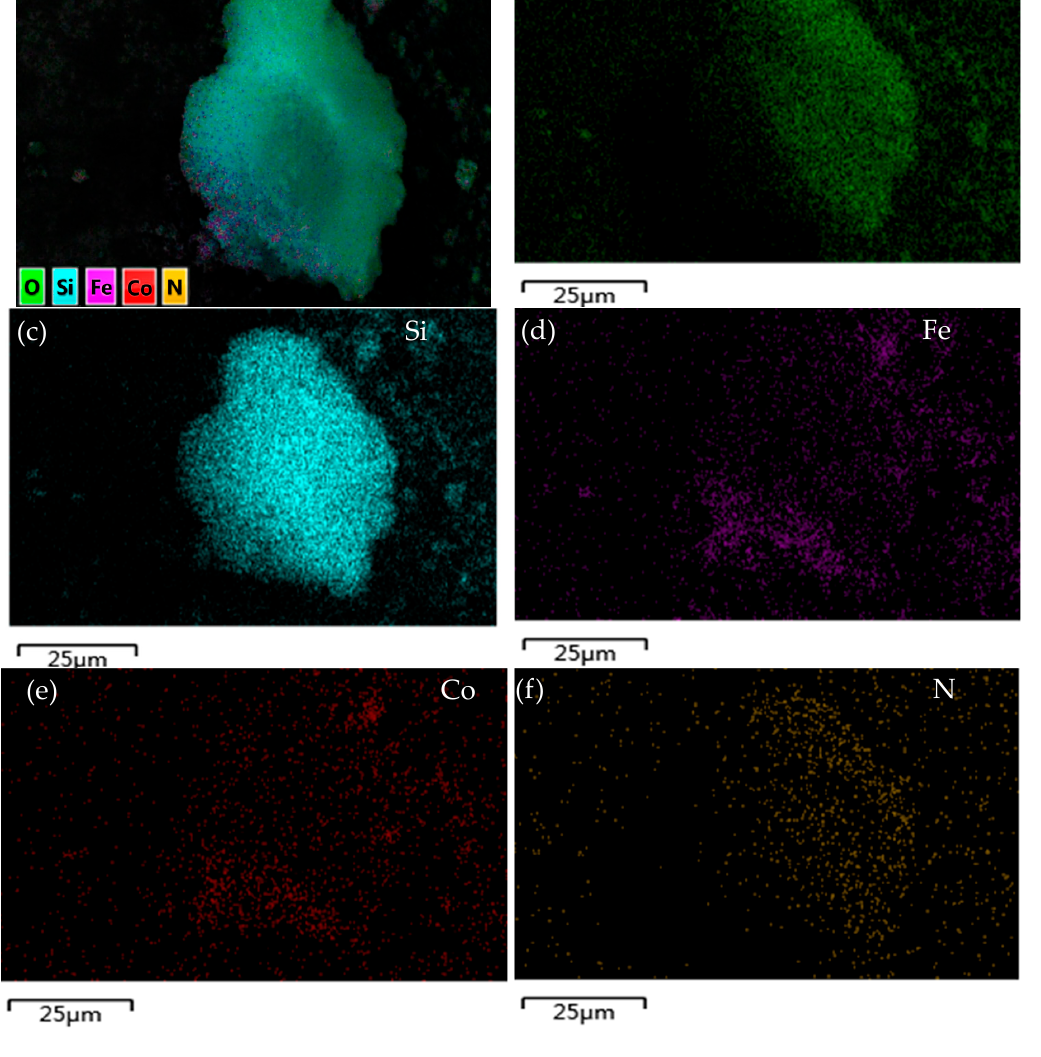
Figure 3. ( a ) SEM micrograph with X-ray elemental area scanning of CoFe 2 O 4 @SiO 2 –NH 2 ; ( b ) elemental mapping recorded from one CoFe 2 O 4 @SiO 2 –NH 2 particle with corresponding mappings of O; ( c ) Si; ( d ) Fe; ( e ) Co; ( f ) N before adsorption.